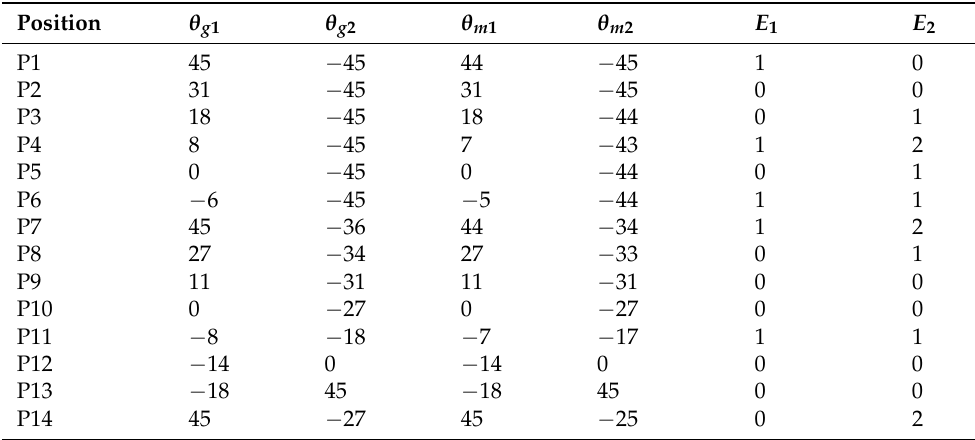
Figure 16. Angle estimation results obtained for P1–P32 ( y = 0, 5, 10, 15, and 20). Table 9 presents the estimated angles and error values. The mean error values of M1 and M2 were, respectively, 0.28 ◦ and 0.53 ◦ . The error values were smaller than 2 ◦ because an effective angular range smaller than ± 45 ◦ was used. Table 9. Angle estimation results and errors obtained from Experiment C ( ◦